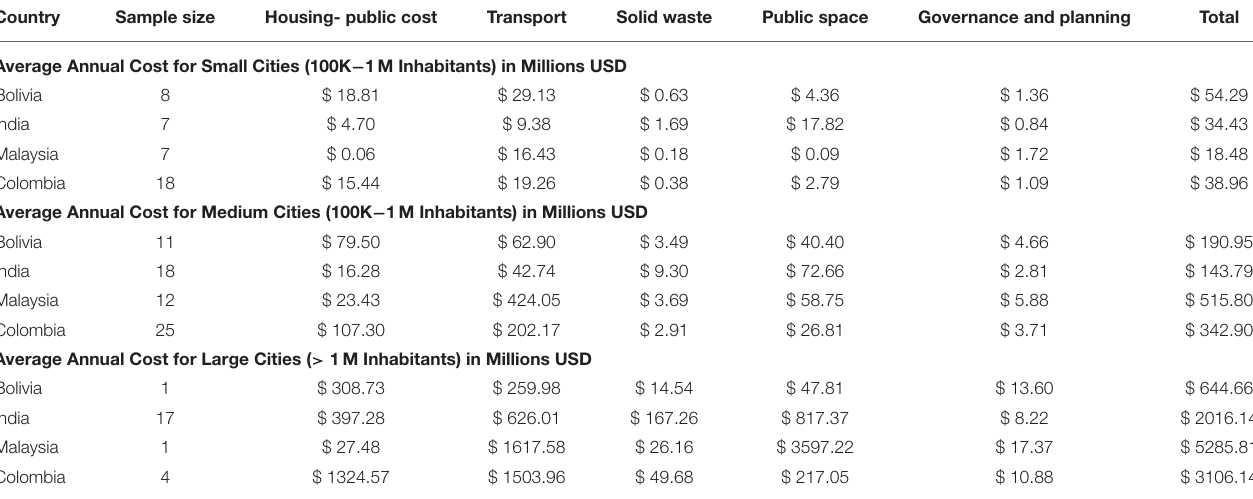
TABLE 2 | Average yearly cost estimates by city size and SDG 11 category. Country Sample